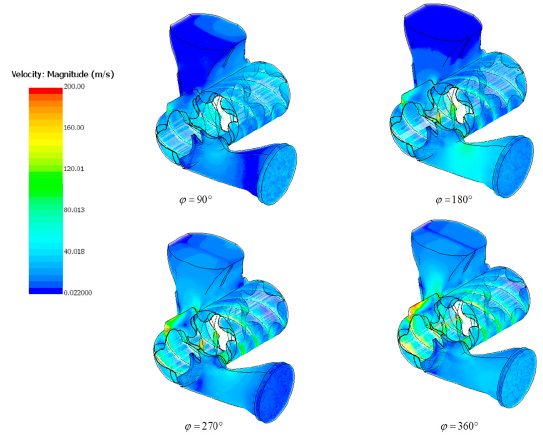
Figure 13. Volume rendering of the velocity distribution according to the angle of rotation.